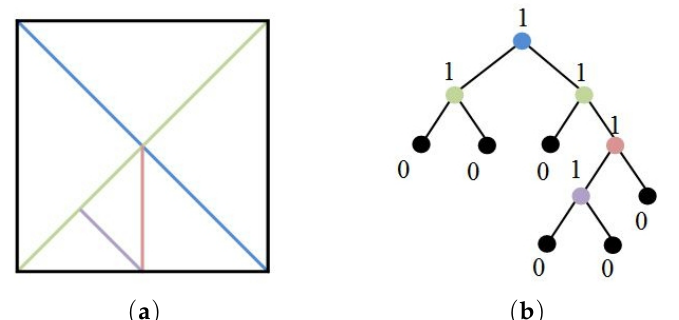
Figure 2. Process of creating the B-tree structure. ( a ) Process of dividing the triangles. ( b ) Corre- sponding binary tree